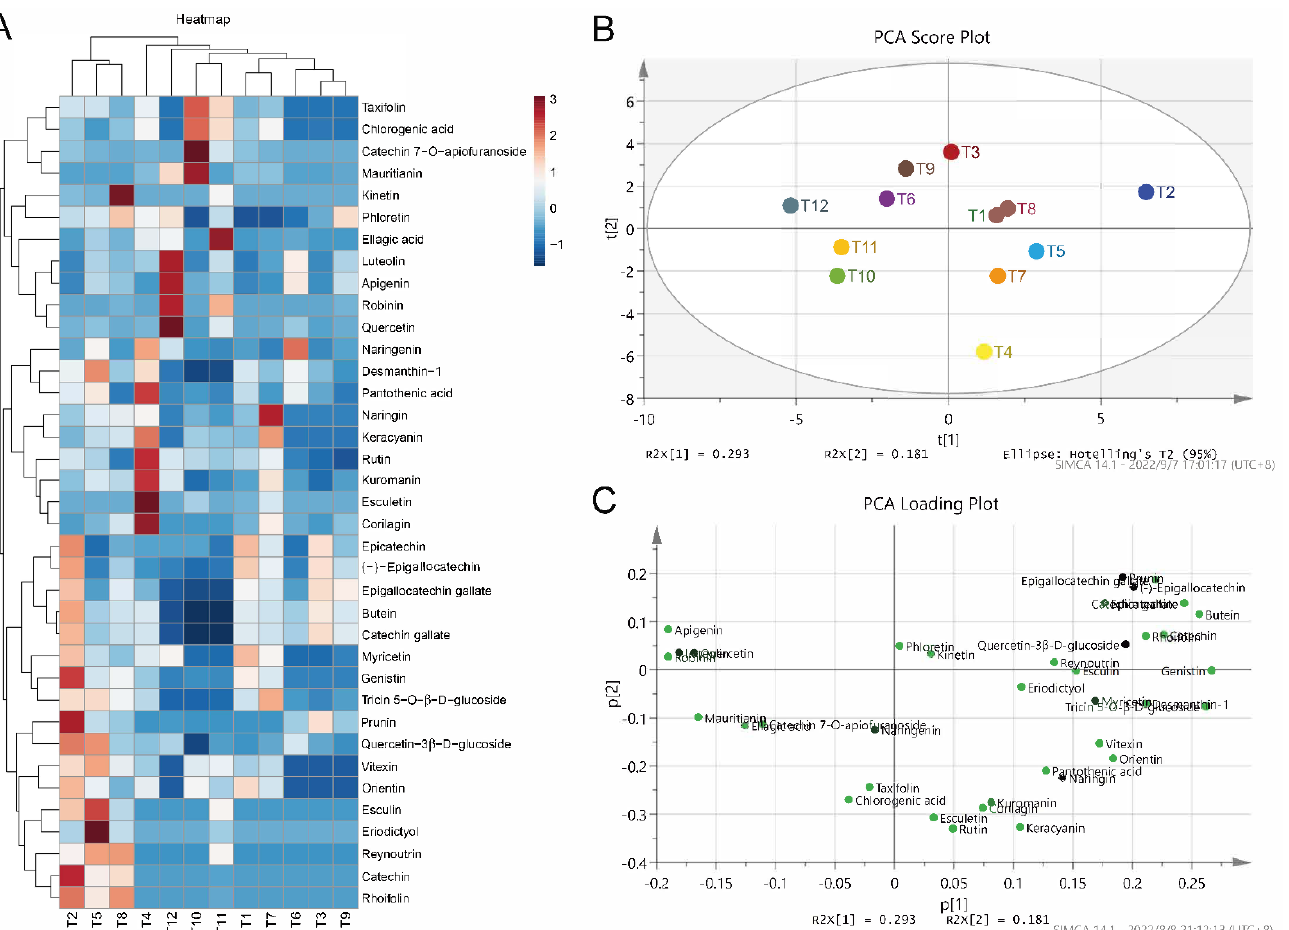
Figure 2. Composition analysis of 12 tea extracts. T1–T3, T4–T6, T7–T9 and T10–T12 are extracts of green tea, black tea, white tea and pu-erh tea in water, 15% ethanol and 75% ethanol, respectively. Heatmap of the components ( A ), PCA score plot ( B ) and PCA loading plot ( C ).